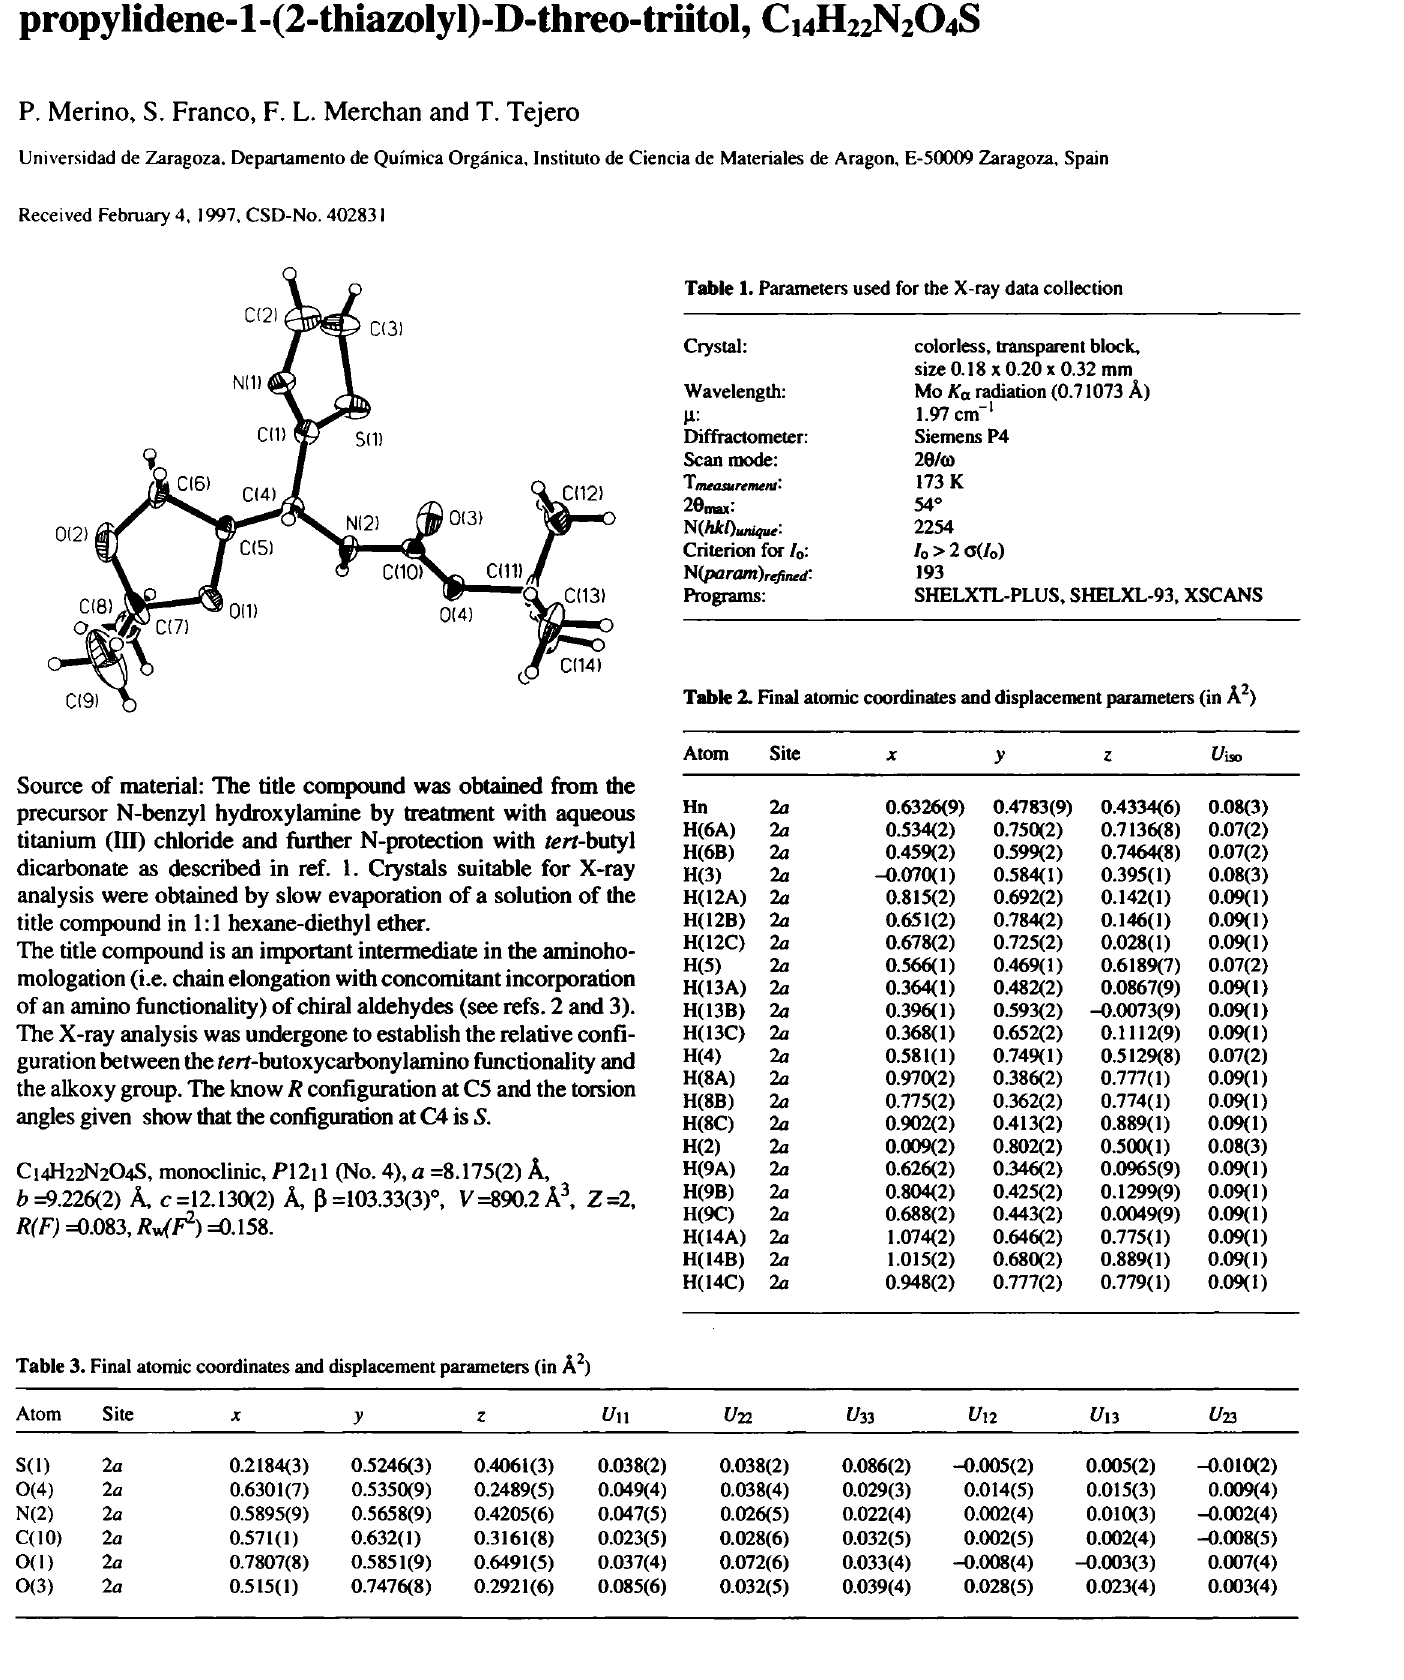
Table 1. Parameters used for the X-ray data collection